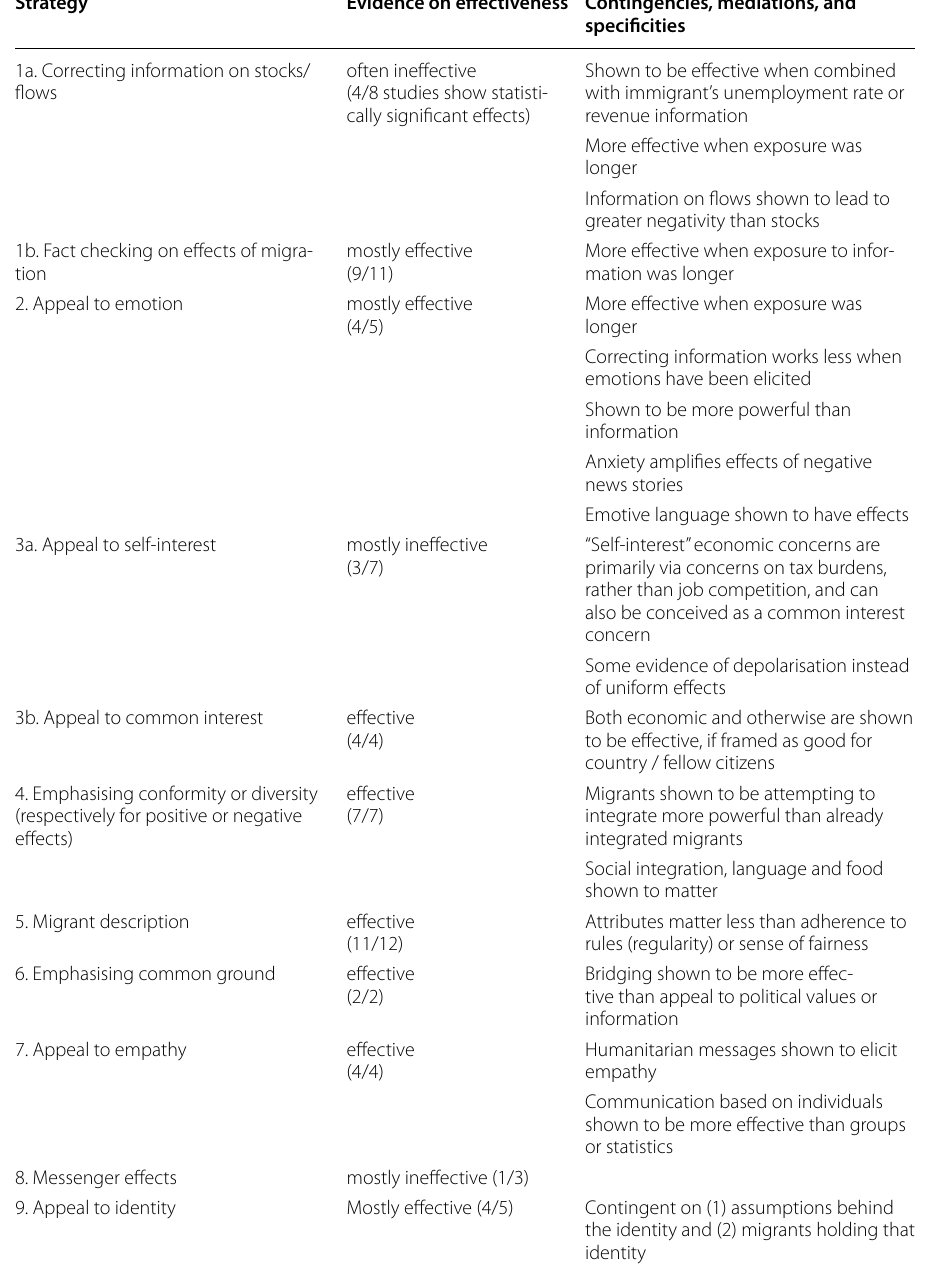
Table 1 Overview of experimental academic findings on migration communication strategies Strategy Evidence on effectiveness Contingencies, mediations, and